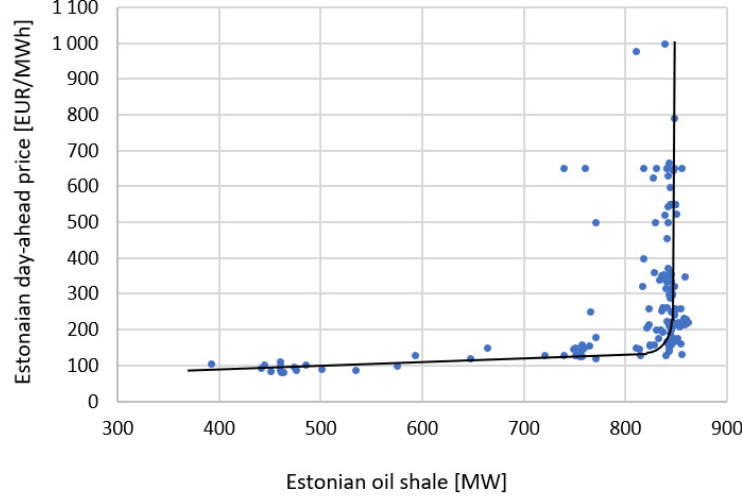
Figure 8. Estonian hourly oil share production against the realised day-ahead market prices for the corresponding hours between 4–9 December 2021.